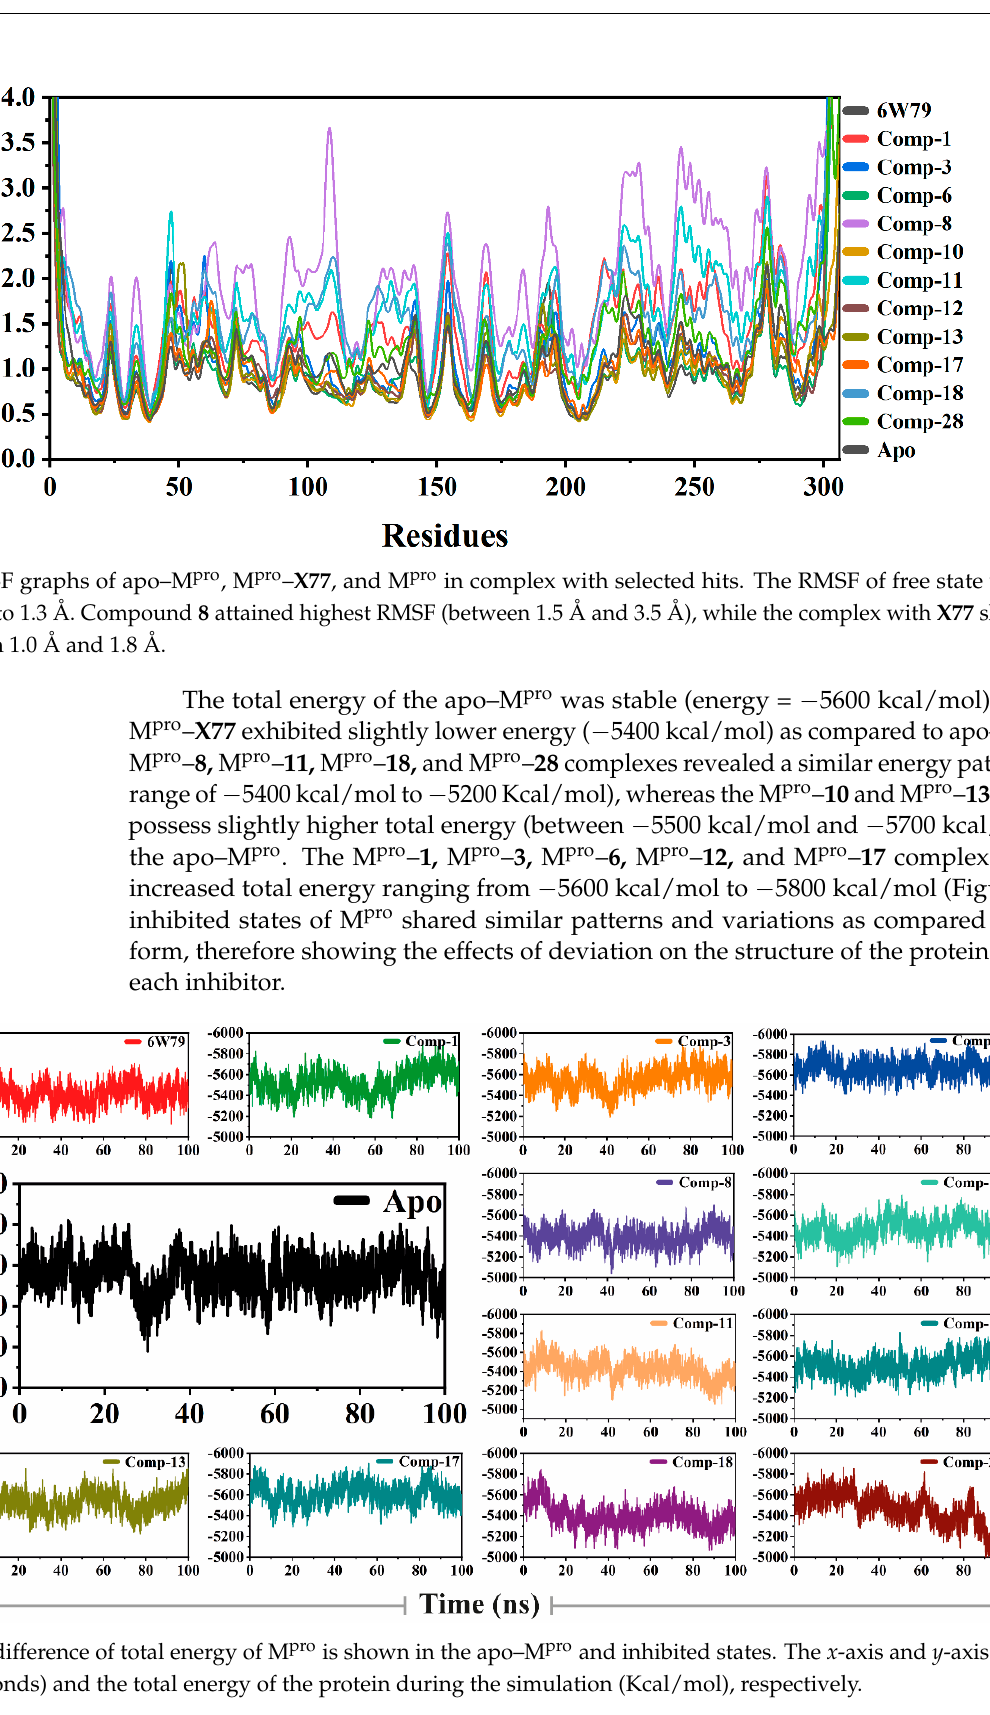
Figure 4. The difference of total energy of M pro is shown in the apo–M pro and inhibited states. The x -axis and y -axis depict time (nanoseconds) and the total energy of the protein during the simulation (Kcal/mol),